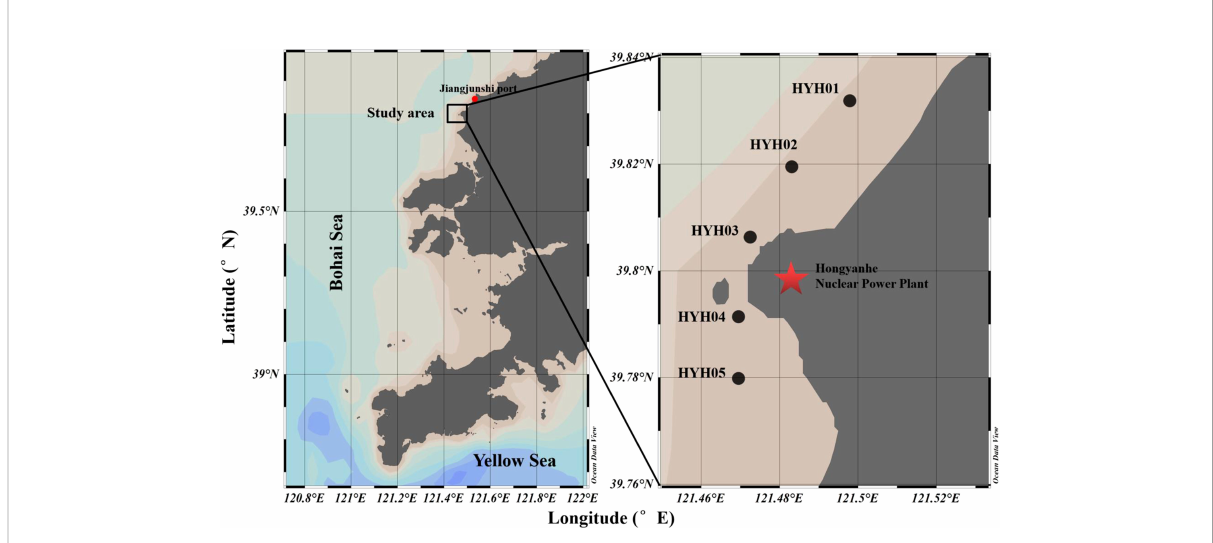
FIGURE 1 Location of the study area. The area from where the ephyrae were collected and the HYHNPP are delimited by the red dot and the red pentacle,